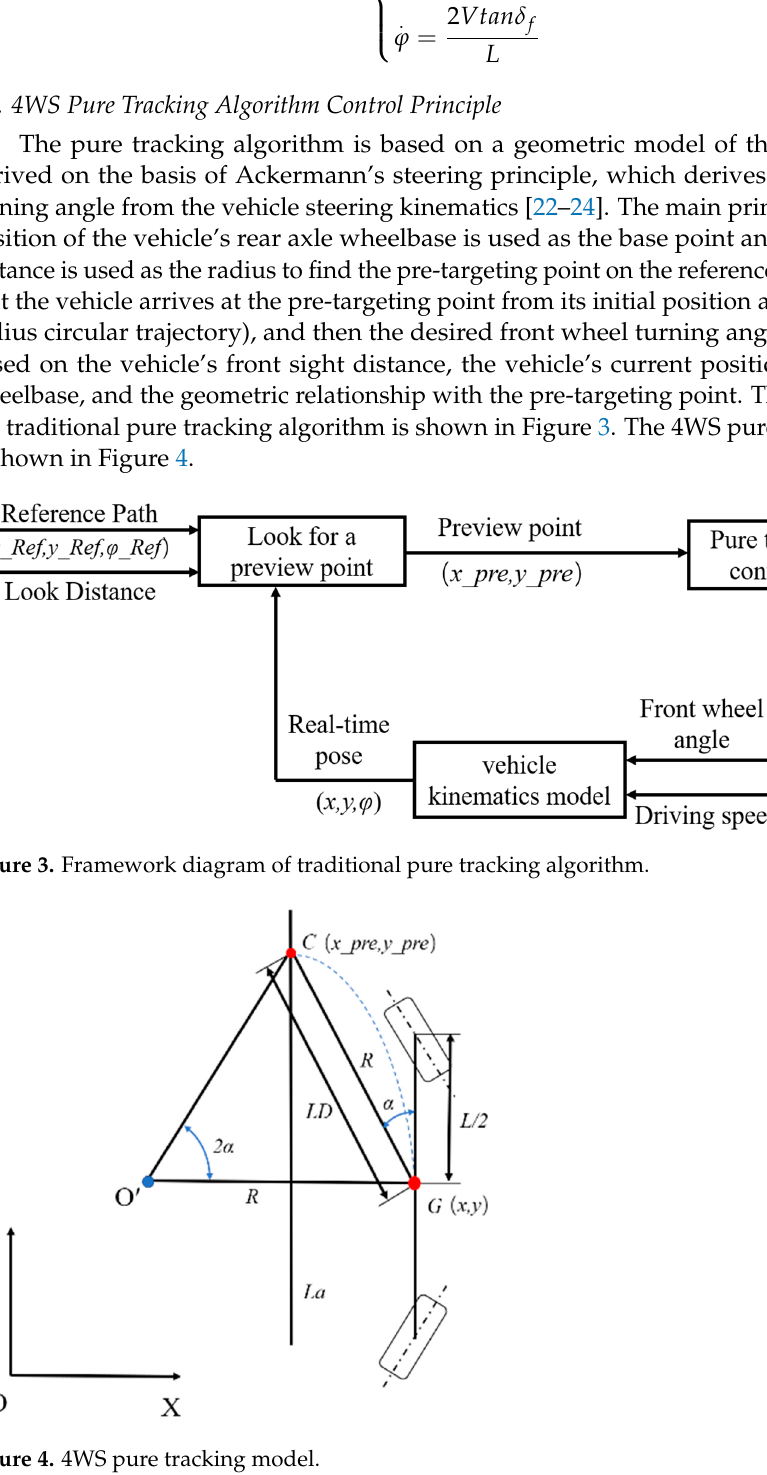
Figure 4. 4WS pure tracking model.